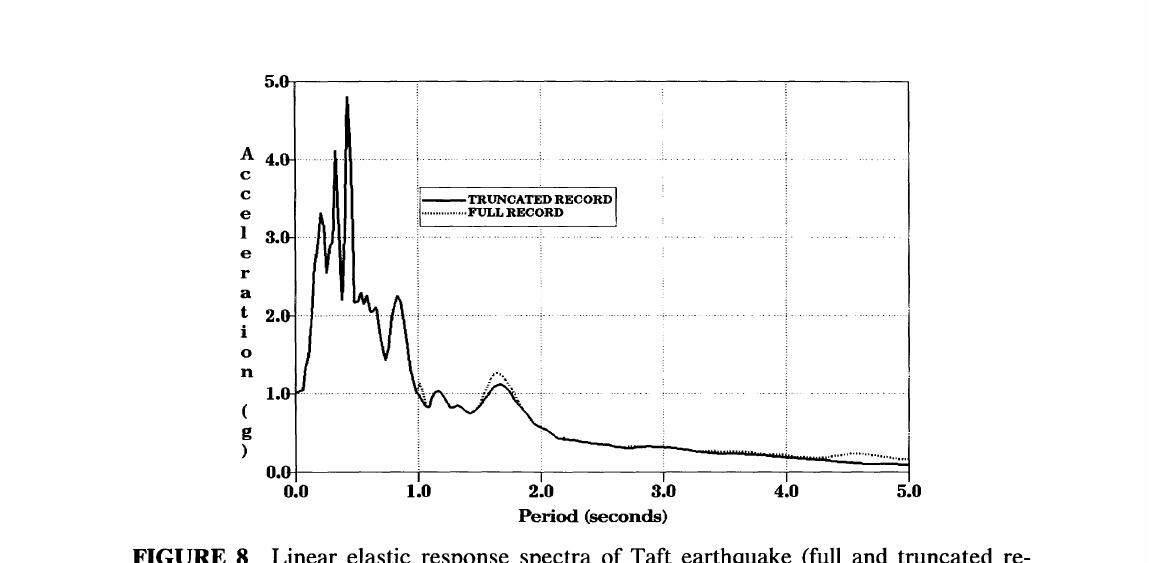
FIGURE 8 Linear elastic response spectra of Taft earthquake (full and truncated re